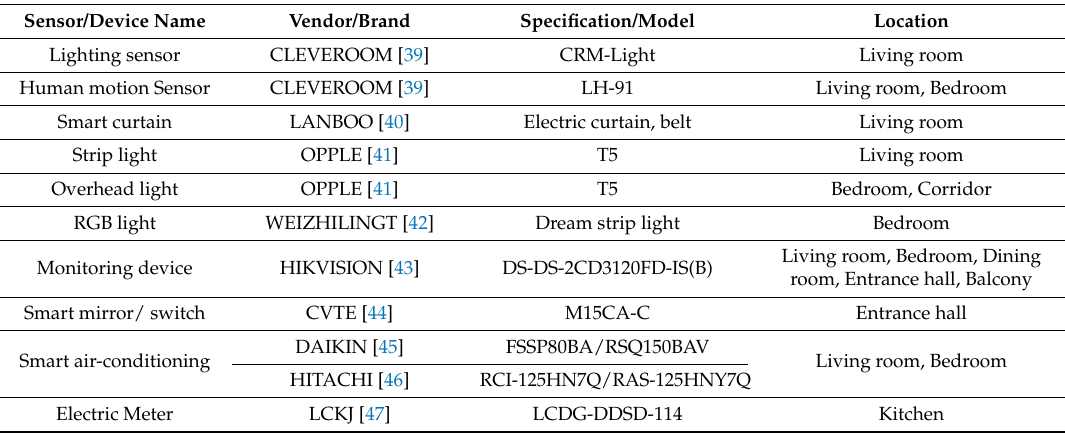
Table A1. Details of some smart devices in our smart home